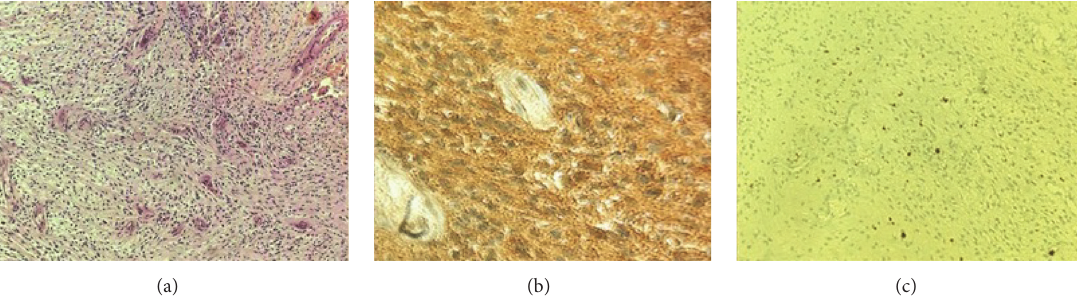
Figure 7: (a) Hematoxylin and Eosin, 20x: the classical histopathology of a schwannoma, hypercellular matrix composed of spindle cells with elongated nuclei, (b) with strong positive S100 immunostaining, and (c) rare mitotic figures outlined with Ki-67